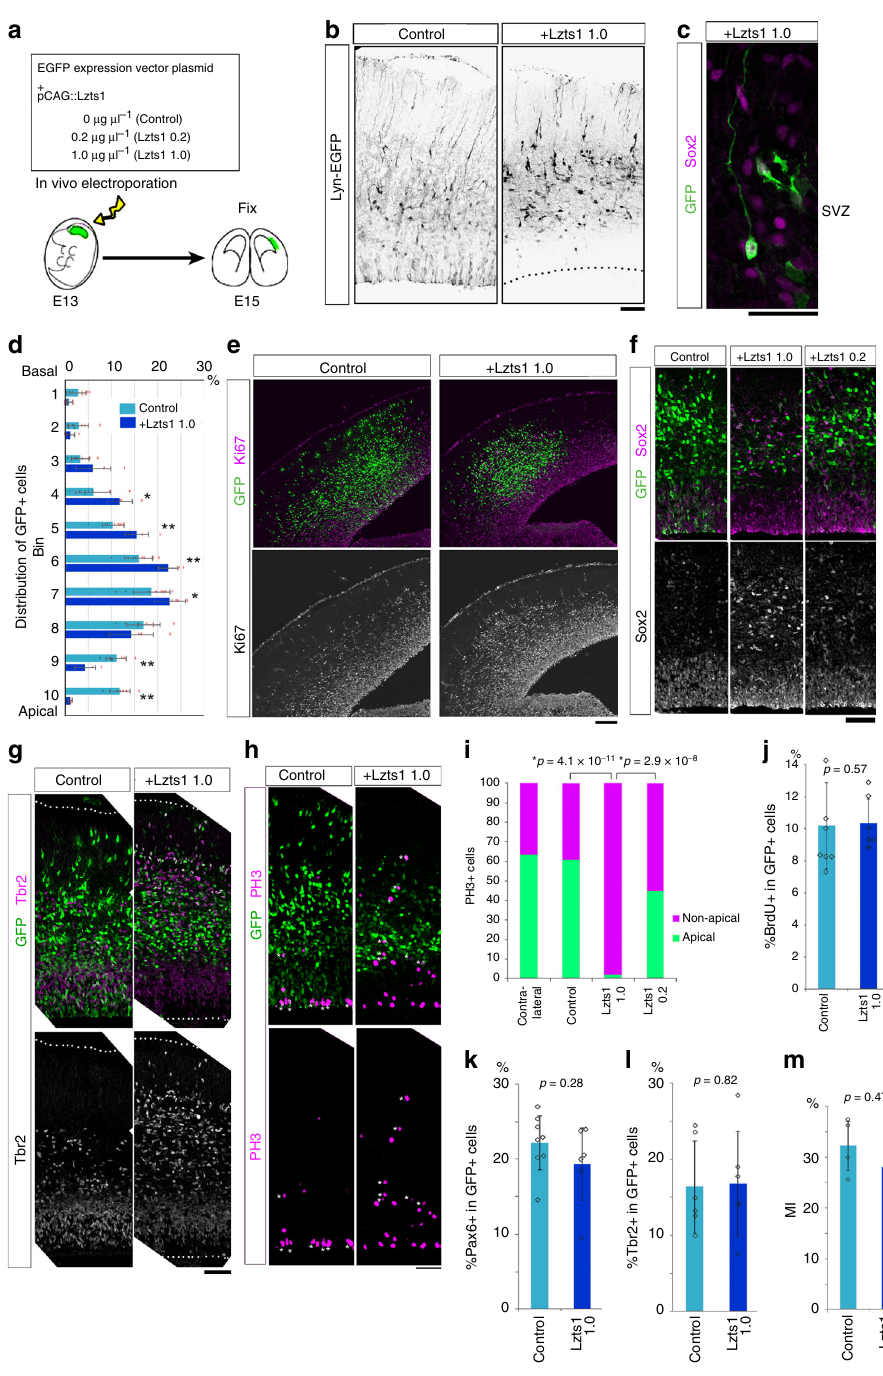
Fig. 5 Lzts1 overexpression positions cells outside the VZ. a Experimental design. b Lzts1 overexpression (1.0 μ g μ l − 1 ) promotes the detachment of cells from the VZ surface. Cell morphology was visualized by Cre-mediated Lyn-EGFP (membrane-targeted form of EGFP), which was co-electroporated (2 days after E13 electroporation). c An example of GFP + Sox2 + cells in the SVZ that have long basal processes, which is the typical morphology of oRGs. d – m The Lzts1 expression vector (1.0 μ g μ l − 1 , indicated as “ Lzts1 1.0 ” or 0.2 μ g μ l − 1 , indicated as “ Lzts1 0.2 ” ) was in vivo electroporated at E13, and E15 brain sections were examined by IHC with anti-Ki67 e , anti-Sox2 f , anti-Tbr2 g and l , anti-PH3 h and i , anti-BrdU (30 min of BrdU pulse labeling) j , and anti-Pax6 k antibodies. d Distribution of Lzts1-overexpressing cells in 10 bins throughout the cerebral wall. f Forced expression of Lzts1 at both high (1.0 μ g μ l − 1 ) and moderate (0.2 μ g μ l − 1 ) levels increased the number of Sox2 + GFP + cells in the SVZ. h and i Lzts1 signi fi cantly increases the percentage of non-apical PH3 + mitotic cells in a dose-dependent manner (Fisher ’ s exact test, two-sided, with Bonferroni-adjusted P value p < 0.05/6 = 0.0083). The asterisk in h indicates a PH3 + GFP + cell. m The mitotic index (MI) indicates the percentage of Ki67 + cells among BrdU + GFP + cells that received BrdU 20 h before fi xation. d N = 8 sections from 4 embryos per experiment; i N = 343, 56, 46, and 91 cells from 11, 9, 6, and 12 brain sections from 7, 4, 3, 4 embryos, respectively; j N = 8, 6; k N = 8, 6; l N = 6, 6; and m N = 4, 6 sections from three embryos per experiment, d * p < 0.05 and ** p < 0.01, d and j – m Wilcoxon rank sum test. Bars, 50 μ m in b , and f – h , 30 μ m in c , 100 μ m in e . Means ± s.d. Source data are provided as a Source Data fi le